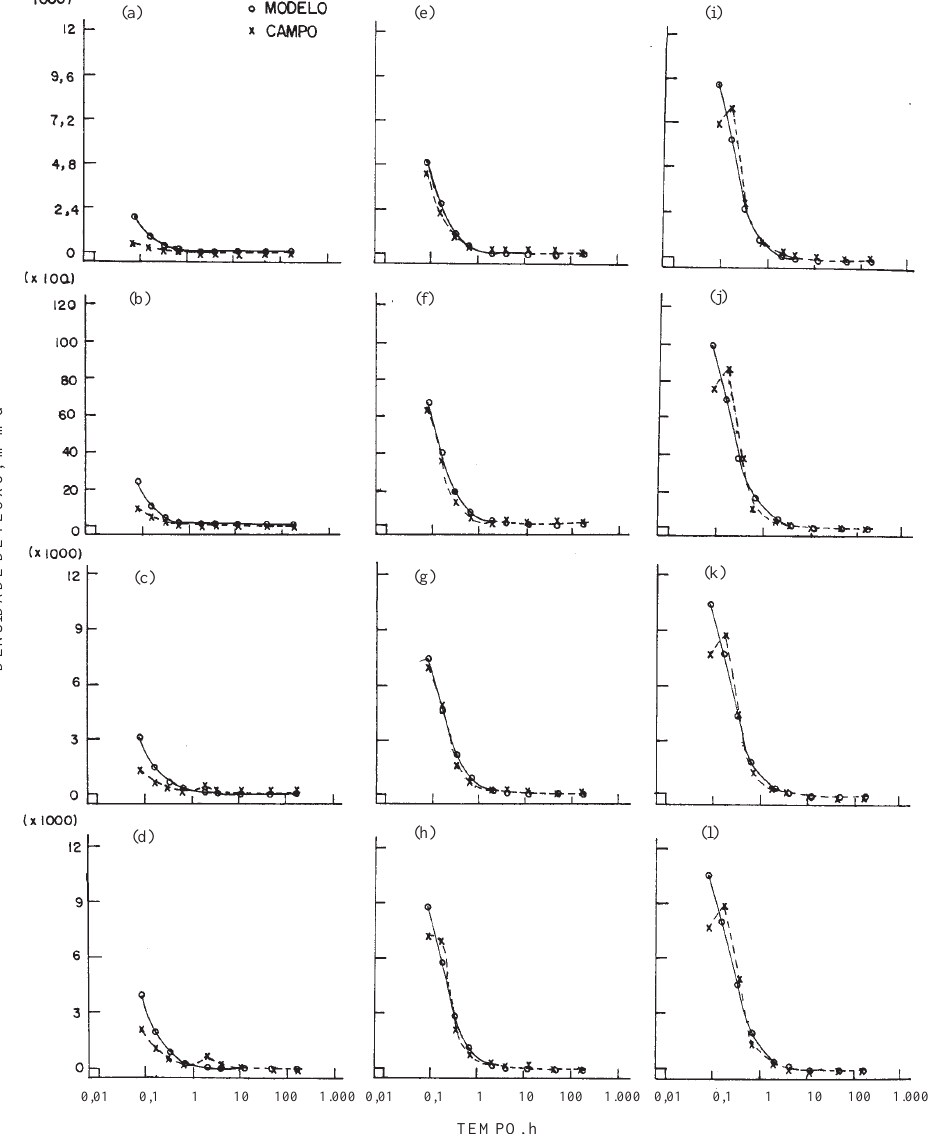
Figura 3. Densidade de fluxo em função do tempo, obtida mediante modelo numérico de Prevedello (1996) e dados de Cho et al. (1977). (As letras a, b, ..., l indicam as profundidades de 0,05; 0,10; 0,15; 0,20; 0,30; 0,40; 0,50; 0,60; 0,70; 0,80; 0,90; e 1,00 m,